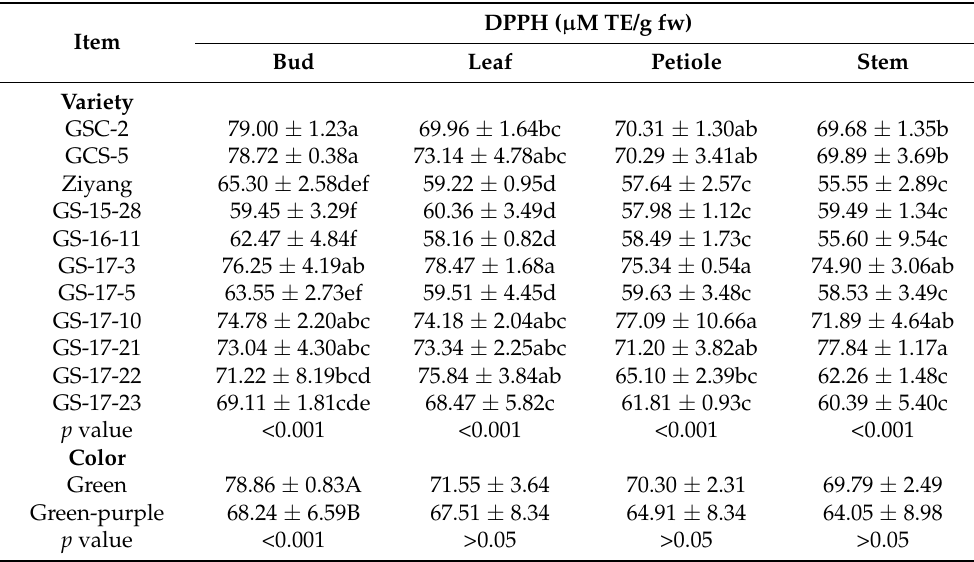
Table 2. The 2,2-diphenyl-1-picrylhydrazyl (DPPH) radical scavenging assay of buds, leaves, petioles, and stems of 11 leafy sweet potato varieties.